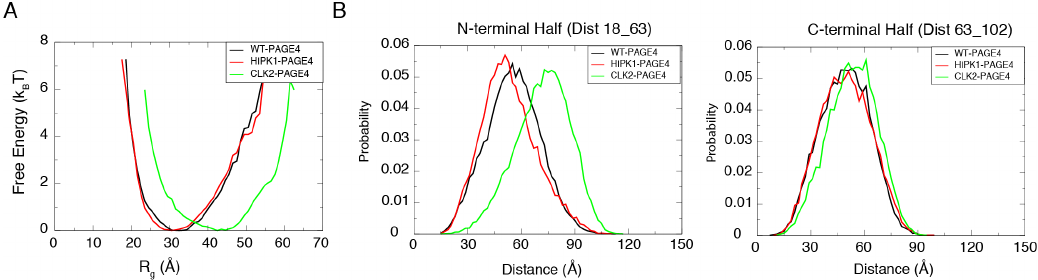
Figure 2. The simulations reproduce the size preference of PAGE4 ensembles at different phosphorylation states. ( A ) The free energy profiles as a function of the radius of gyration ( R g ) of the simulated ensemble